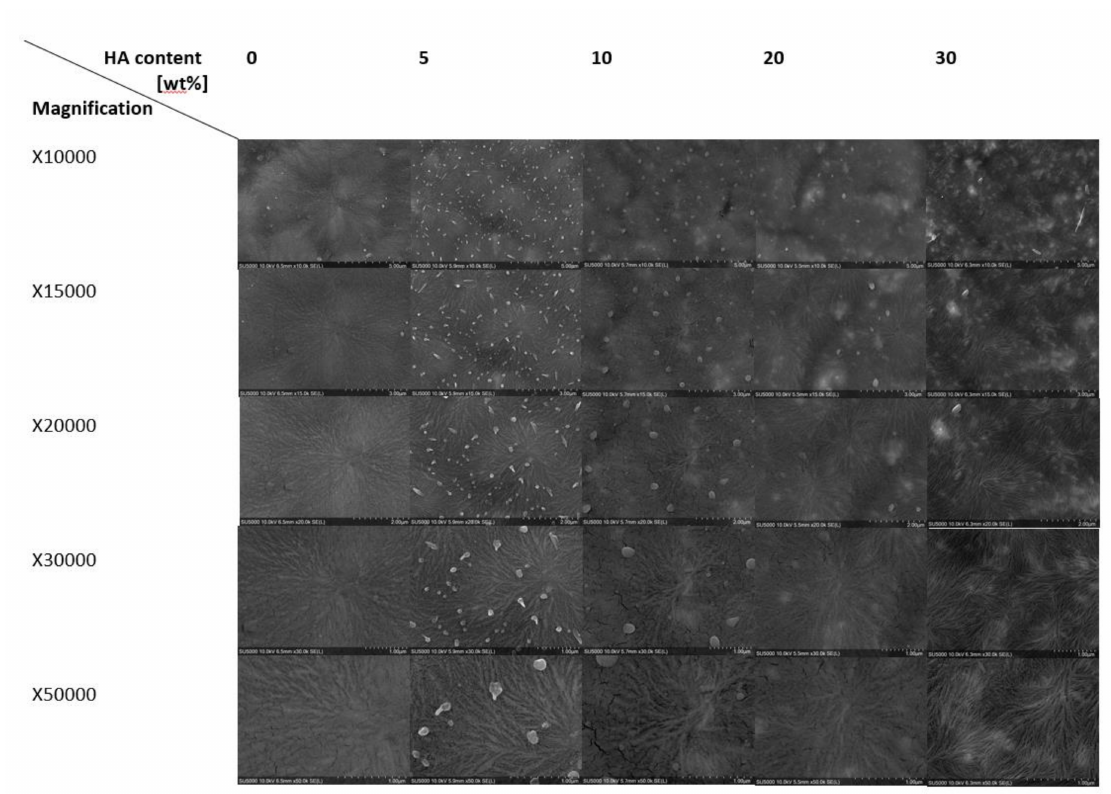
Figure A3. Scanning electron microscope images for rectangular PEEK specimens as 3D printed with HA content between 0–30